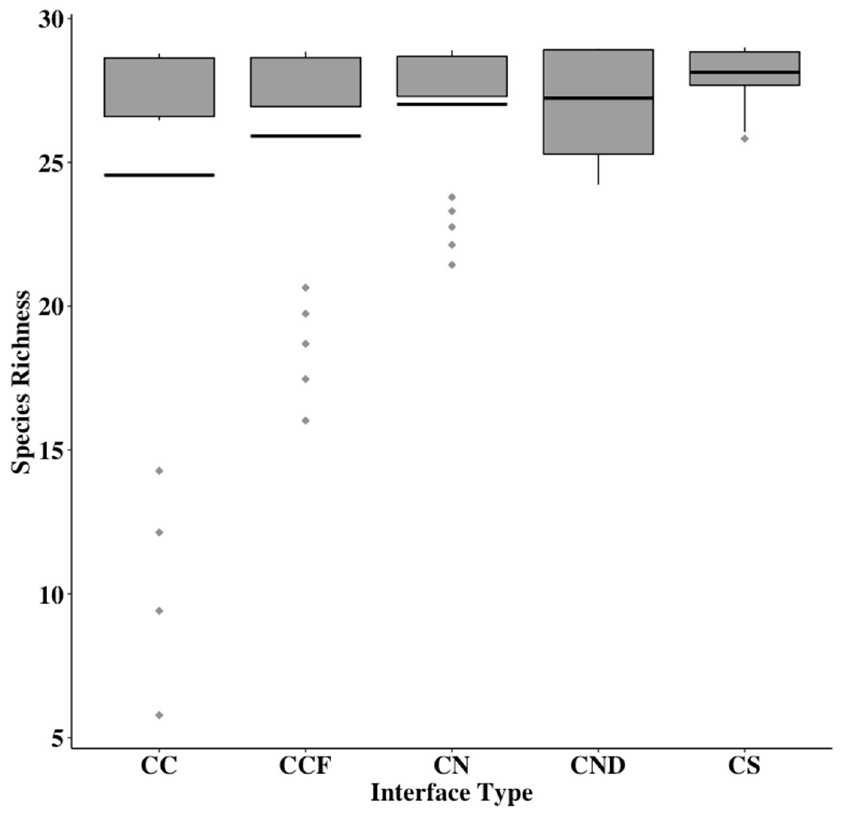
Figure 3. Species richness calculated from bee-bowl collections in both years (2017 and 2018 combined) shown as boxplots across interfaces from bee-bowl collections in a large-scale cotton agroecosystem. Interface types were sites between a cotton field and another cotton field (CC), a sorghum field (CS), semi-natural habitat (CN), another cotton field 1 km away from semi-natural habitat (CCF) and semi-natural habitat alone (NH). The solid black bar gives treatment mean, boxes give the 1st and 3rd quartiles, and diamonds show outliers.